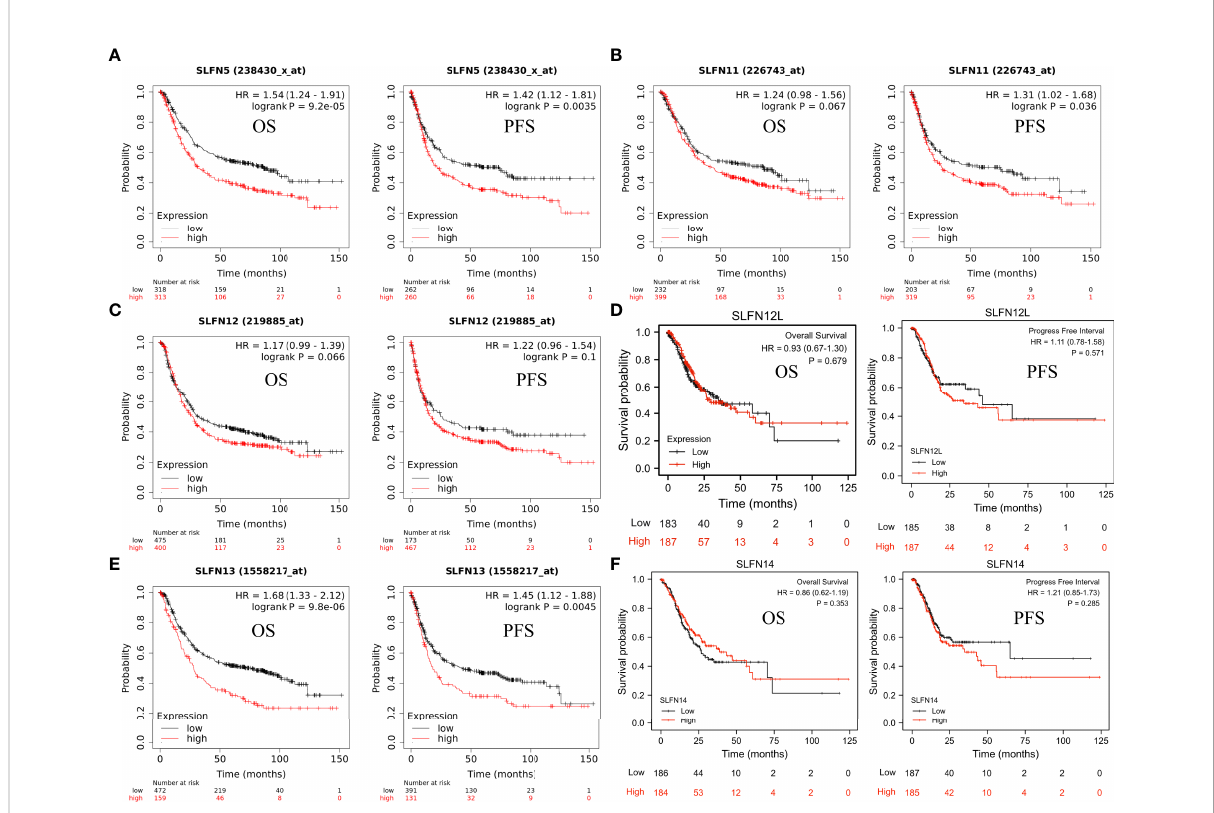
FIGURE 3 Prognostic value of SLFN family in GC. (A-F) The relationship between mRNA expression of different SLFN family members and OS and PFS in gastric cancer. (A, E) High SLFN5 and SLFN13 mRNA expression associated with poor OS and PFS in patients with gastric